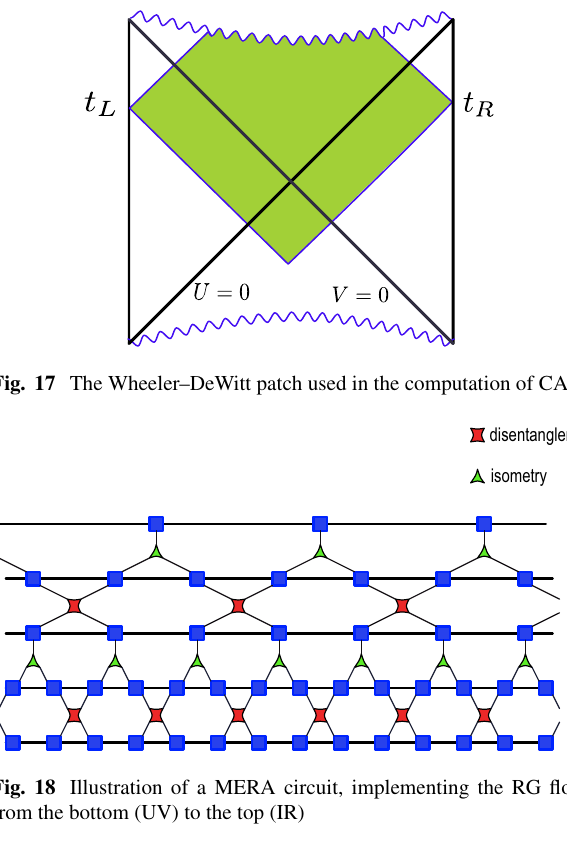
Fig. 18 Illustration of a MERA circuit, implementing the RG flow from the bottom (UV) to the top (IR) ment is introduced in the state at increasingly larger length